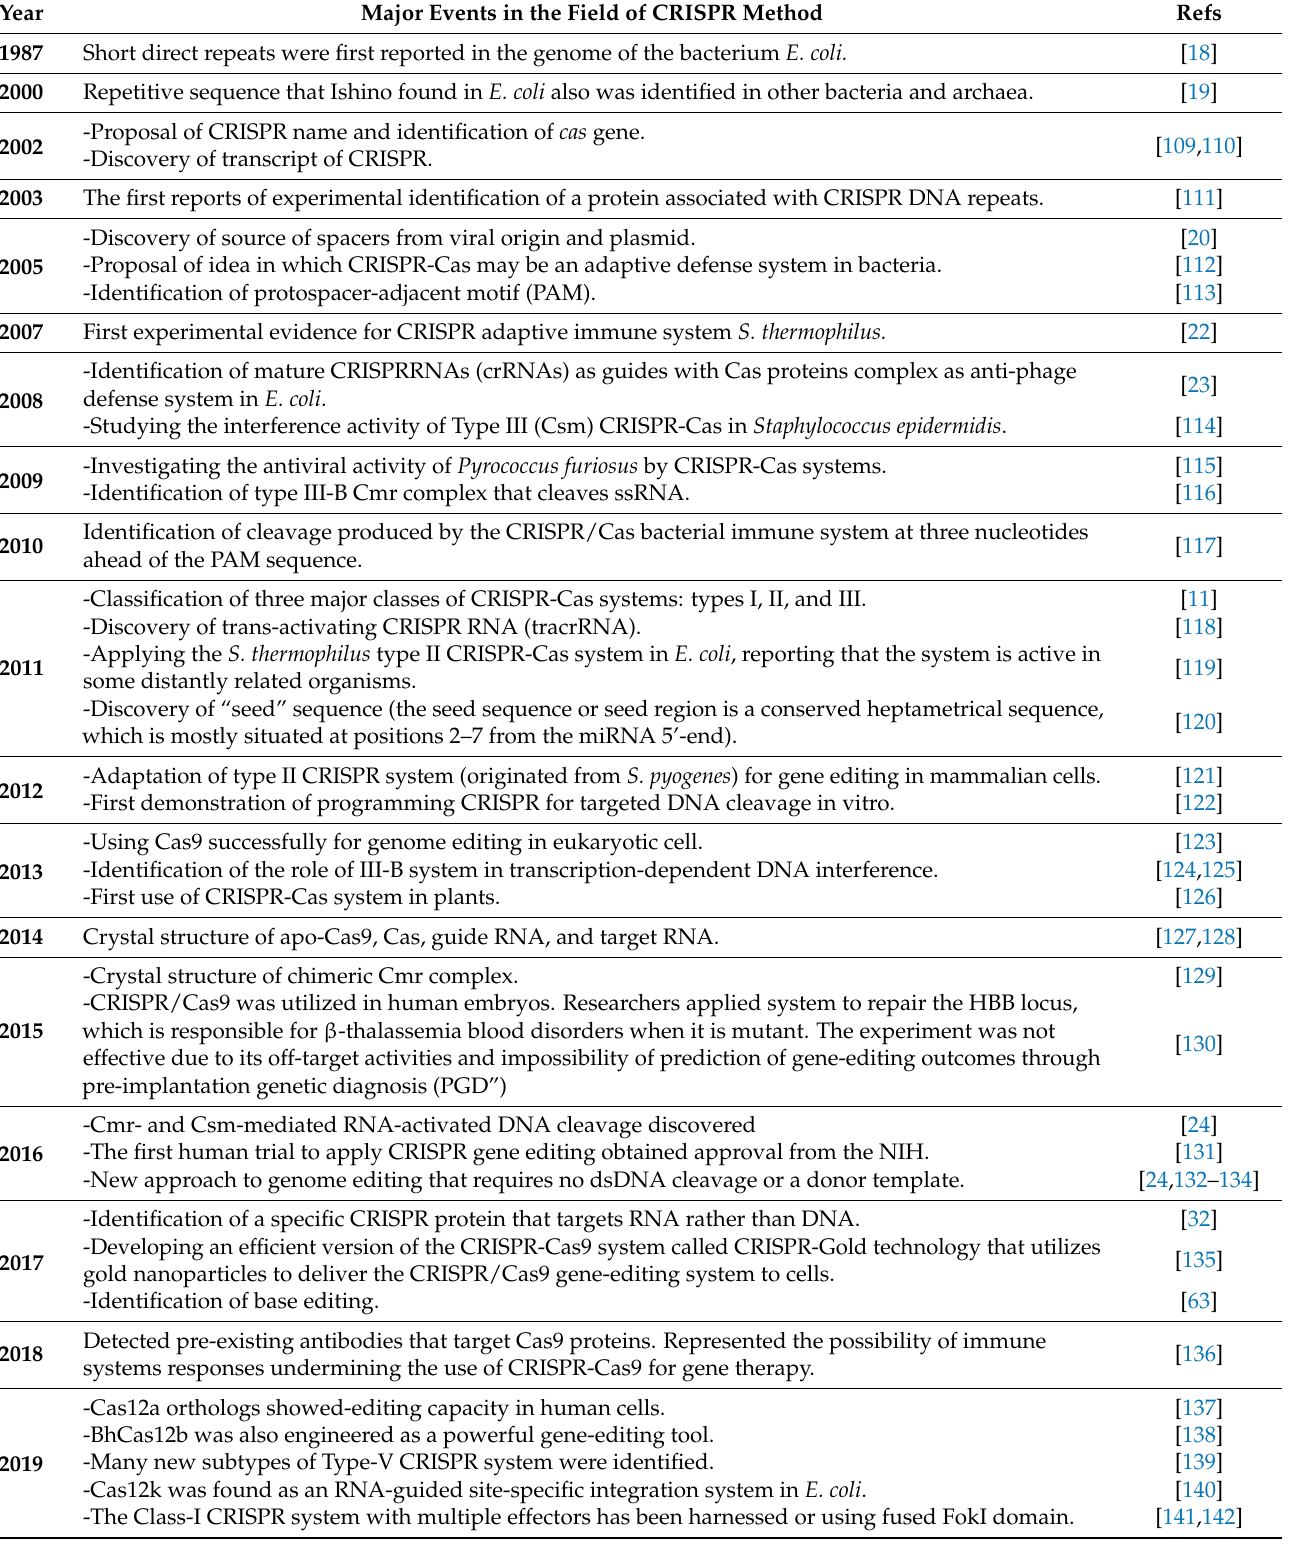
Table 2. A brief history of major events in the field of CRISPR